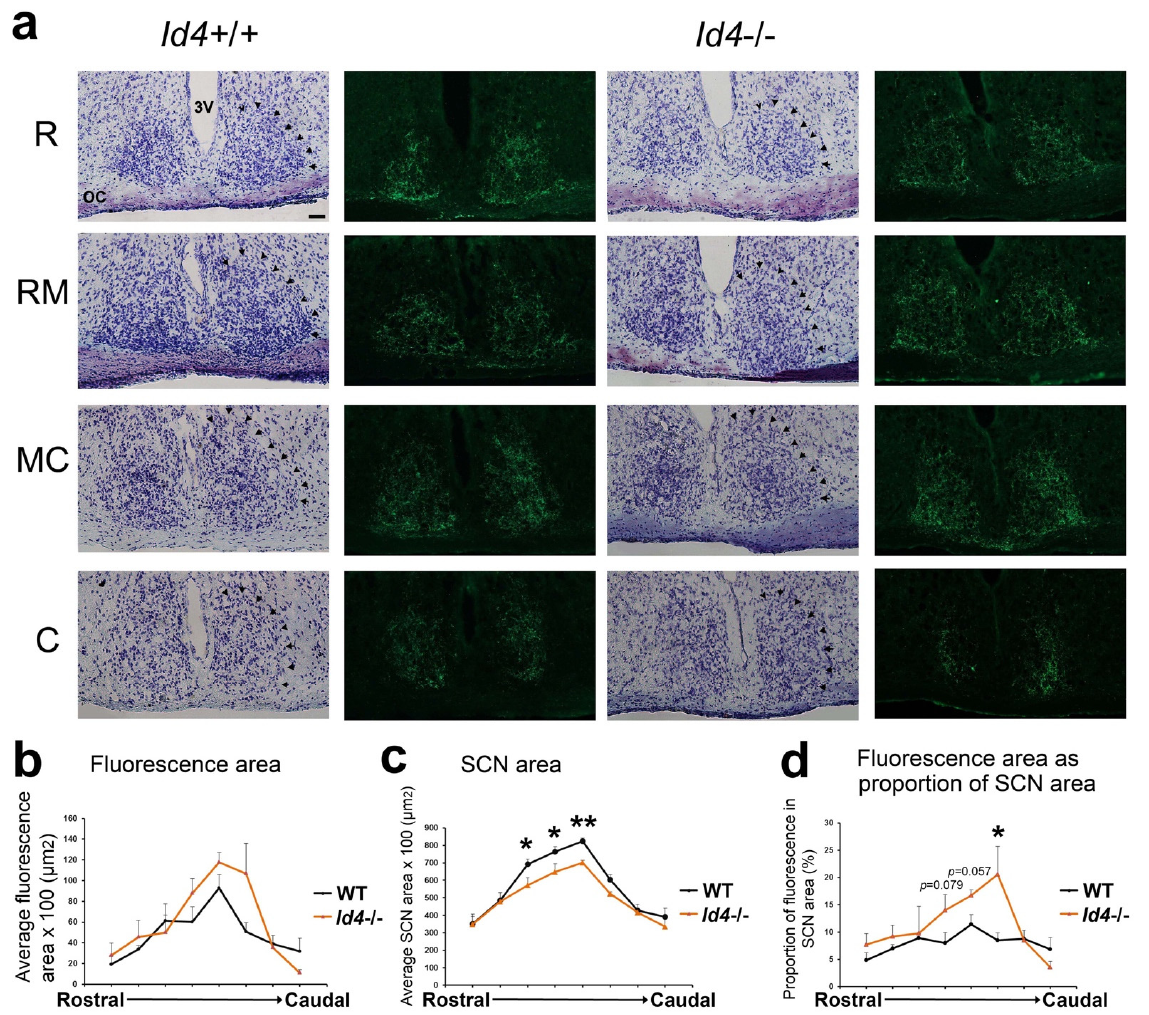
Figure 6. Tracing the retinohypothalamic tract (RHT) of Id4 +/+ and Id4 − / − mice. ( a ) Fluorescence and light microscopy images of the coronal aspect of the SCN from the rostral (R), through to rostral ‐ medial (RM), medial ‐ caudal (MC), and caudal (C) portions of the SCN. Arrows in cresyl violet ‐ stained coronal sections indicate the perimeter of SCN. OC, optic chiasm; 3V, third ventricle. Scale bar = 50 μ m. The terminal fields of the RHT are visible as green color (Alexa Fluor 488). The densely innervated central and ventro ‐ lateral regions contain a preponderance of terminals from the contralateral retina. ( b ) Fluorescence (terminal field) through SCN (rostral to caudal), ( c ) SCN area, ( d ) fluorescence as a proportion of SCN. (wild type (WT; black), n = 5; Id4 − / − (orange), n = 5). Significant differences were detected in fluorescence of the medial ‐ caudal SCN and the area of the SCN between genotypes indicated by an asterisk (* p < 0.05, ** p < 0.01).